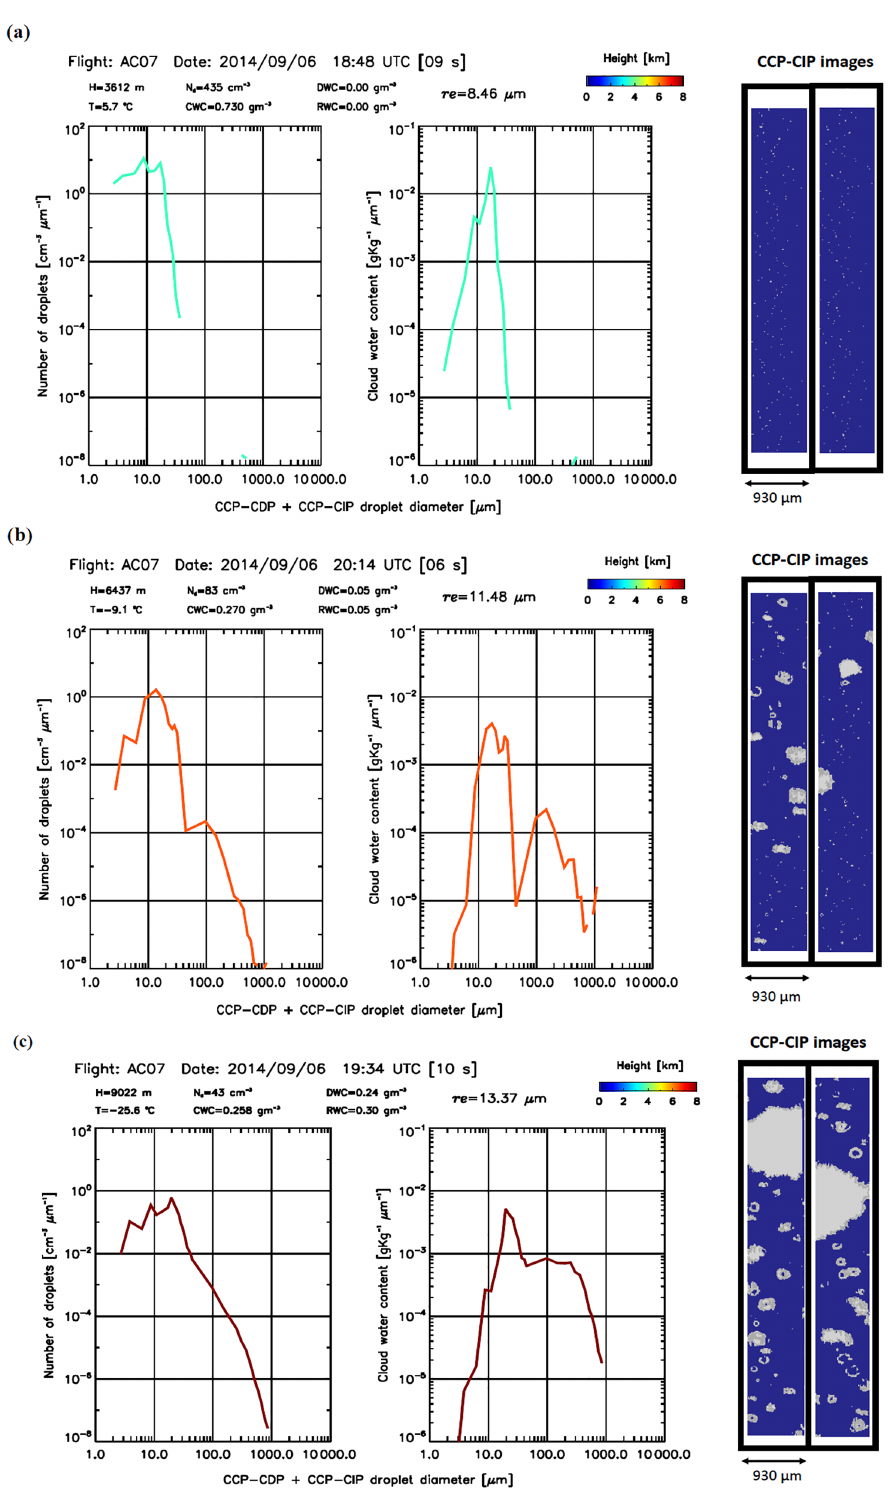
Figure 5. (a–c) Droplet size distribution composite from the CCP–CDP and CCP–CIP probes (left panel). Similar for indicated cloud water content (CWC) in the right panel. Indicated at the top of the panels are the HALO flight number, date, time of flight (UTC), duration of cloud pass in seconds, temperature ( T ) and altitude ( H ) above sea level, and the mean values for the total number of droplets ( N d ) , CWC, DWC, RWC, and r e . The color bars indicate the height of HALO during the cloud pass. On the right side of the panels, CCP–CIP images corresponding to the cloud pass are